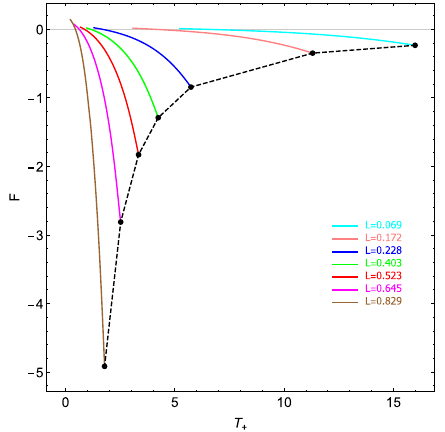
Fig. 7 Free energy F of the thermalon configuration as a function of the temperature T + for various value of L with k = 1, λ = 0 . 12, γ = 0 . 1, γ = 0 . 2 and γ = 0 . a b c